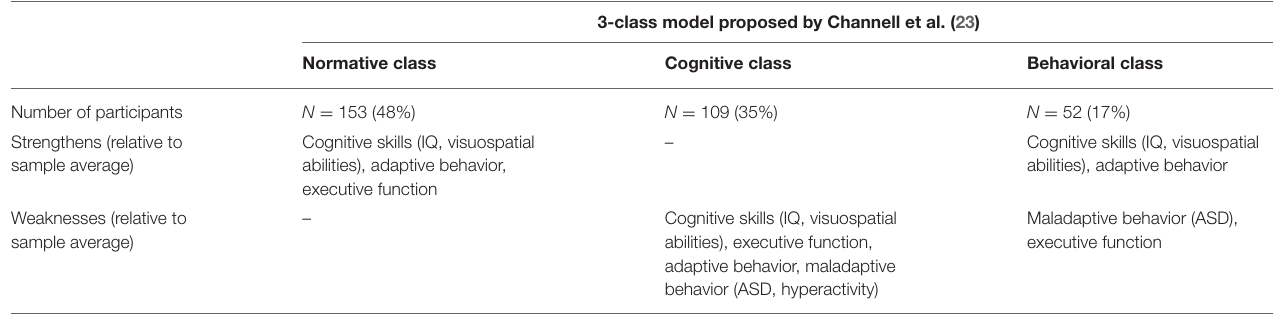
TABLE 1 | Characterization of the 3-class model of individuals with DS ( N = 314; 6–25 years) based on the variability observed in cognitive and behavioral measures, identified by Channell et al. (23) using a latent profile